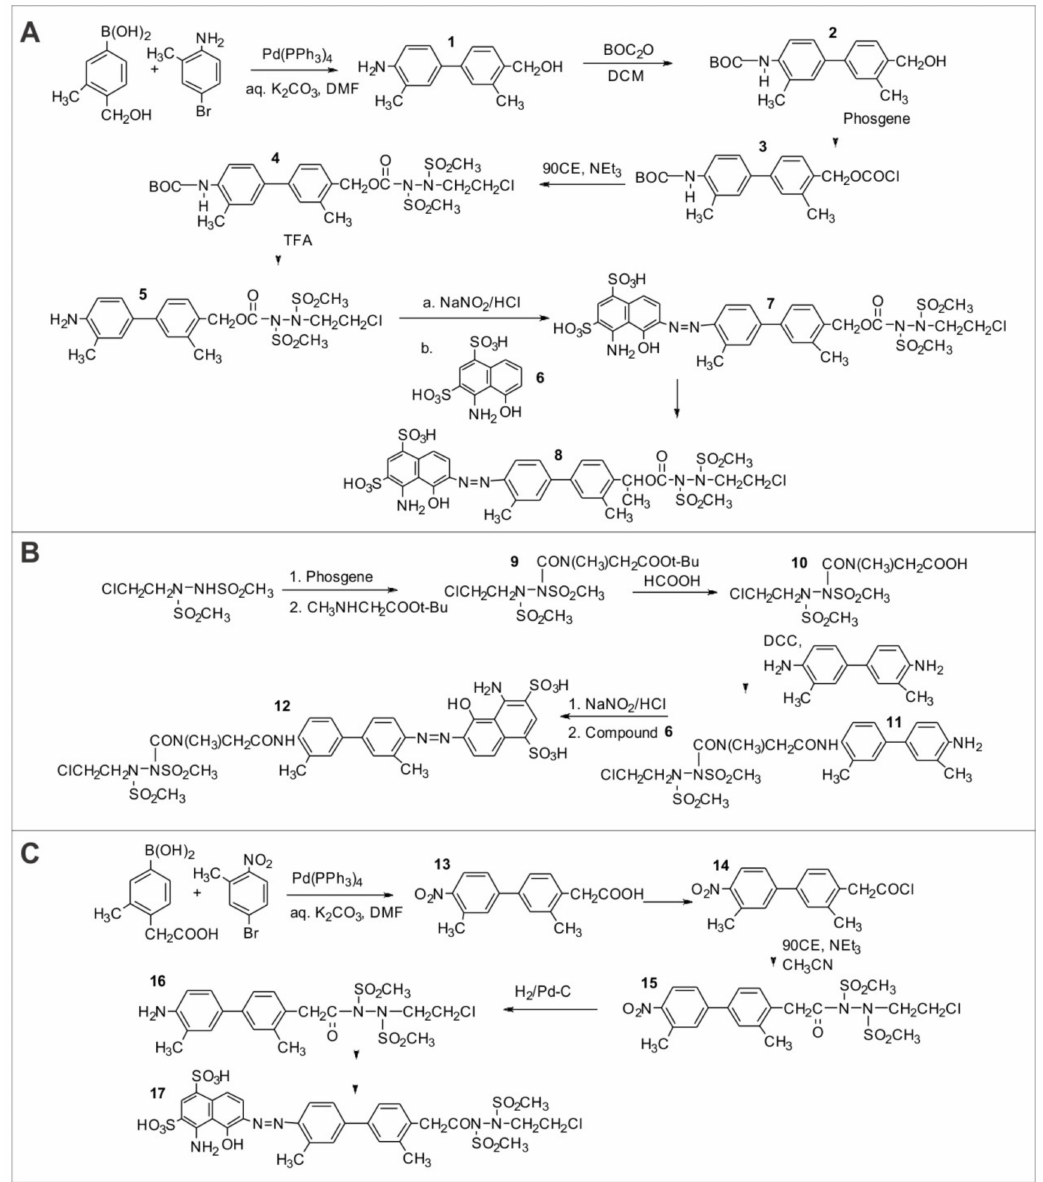
Figure 6. Chemical synthesis. ( A ) Synthesis of BSH-Evans Blue analog covalent conjugates involving carbamate linkages; ( B ) Synthesis of BSH-Evans Blue analog covalent conjugates involving aminocarbonyl linkages; ( C ) Synthesis of BSH-Evans Blue analog covalent conjugates involving acyl